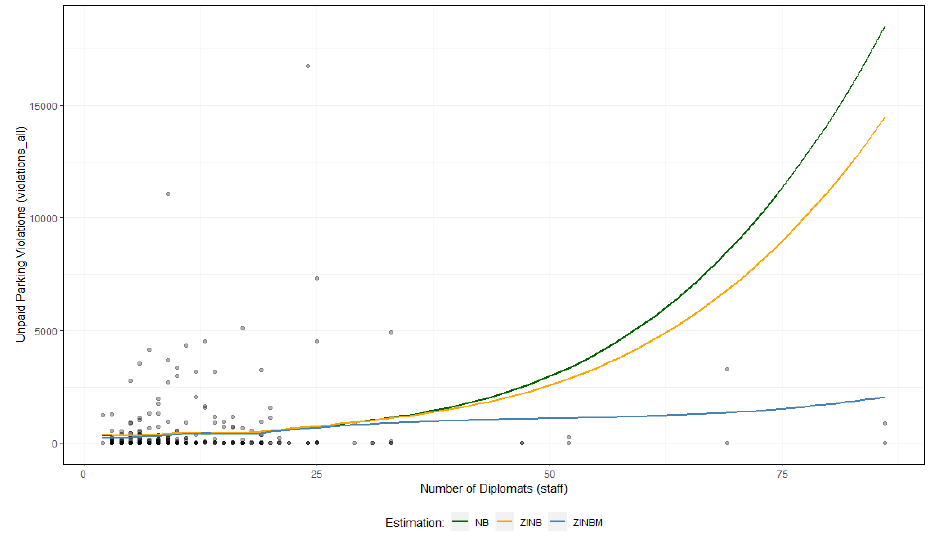
Figure 4. Fitted values of NB, ZINB, and ZINBM estimations, considering the predictor variable staff